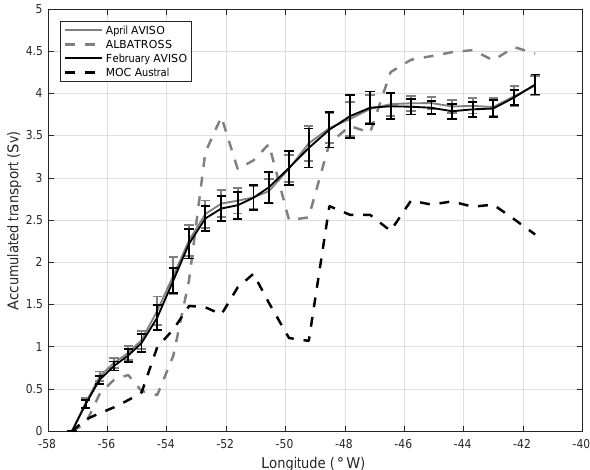
Figure 10. West-to-east accumulated relative geostrophic mass transport from AVISO averaged from 1993 to 2016, together with their standard deviations: April (grey solid line) and February (black solid line). For this calculation, the depth of 50m has been consid- ered to compute the mass transport that corresponds to the SASW stratum. Dashed lines are the west-to-east accumulated relative geostrophic mass transports shown in Fig. 7 for the SASW for AL- BATROSS (grey) and MOC-Austral (black) carried out in April and February,